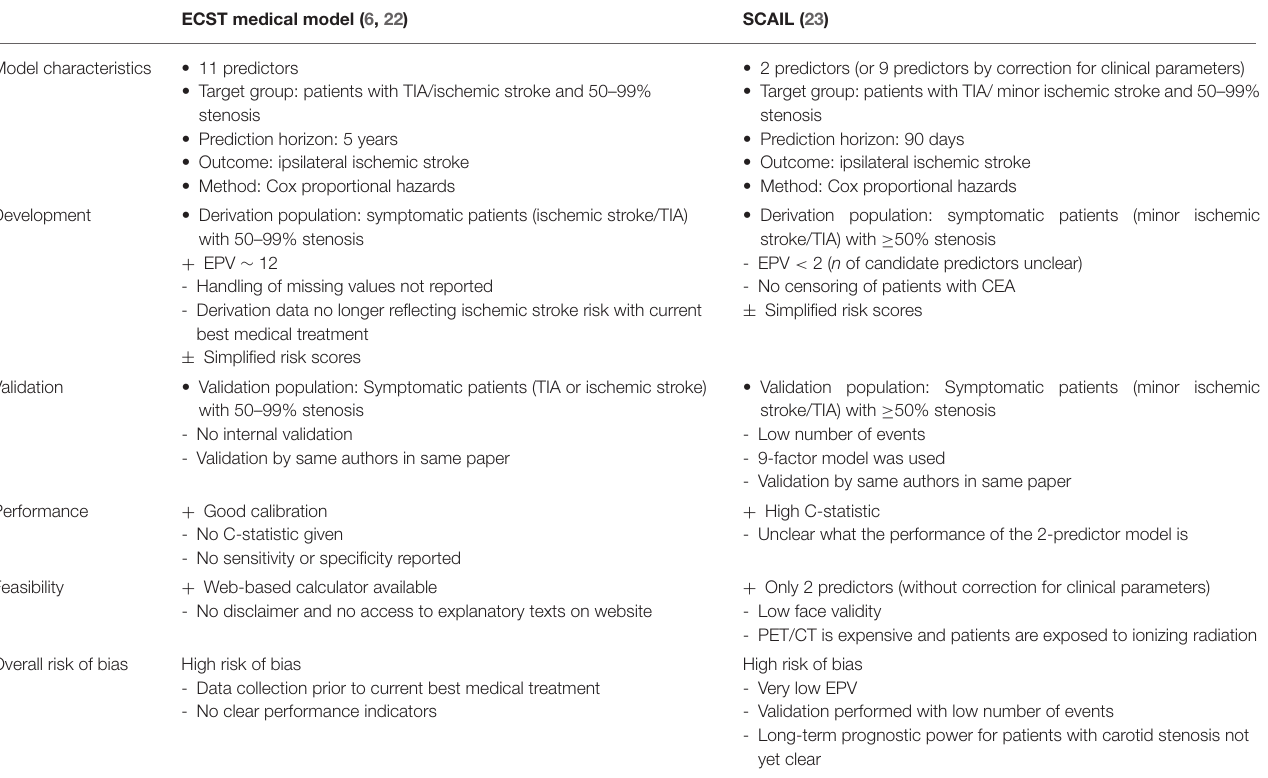
TABLE 1 | Overview and assessment of prediction models of recurrent acute ischemic stroke in patients with carotid stenosis. ECST medical model (6,